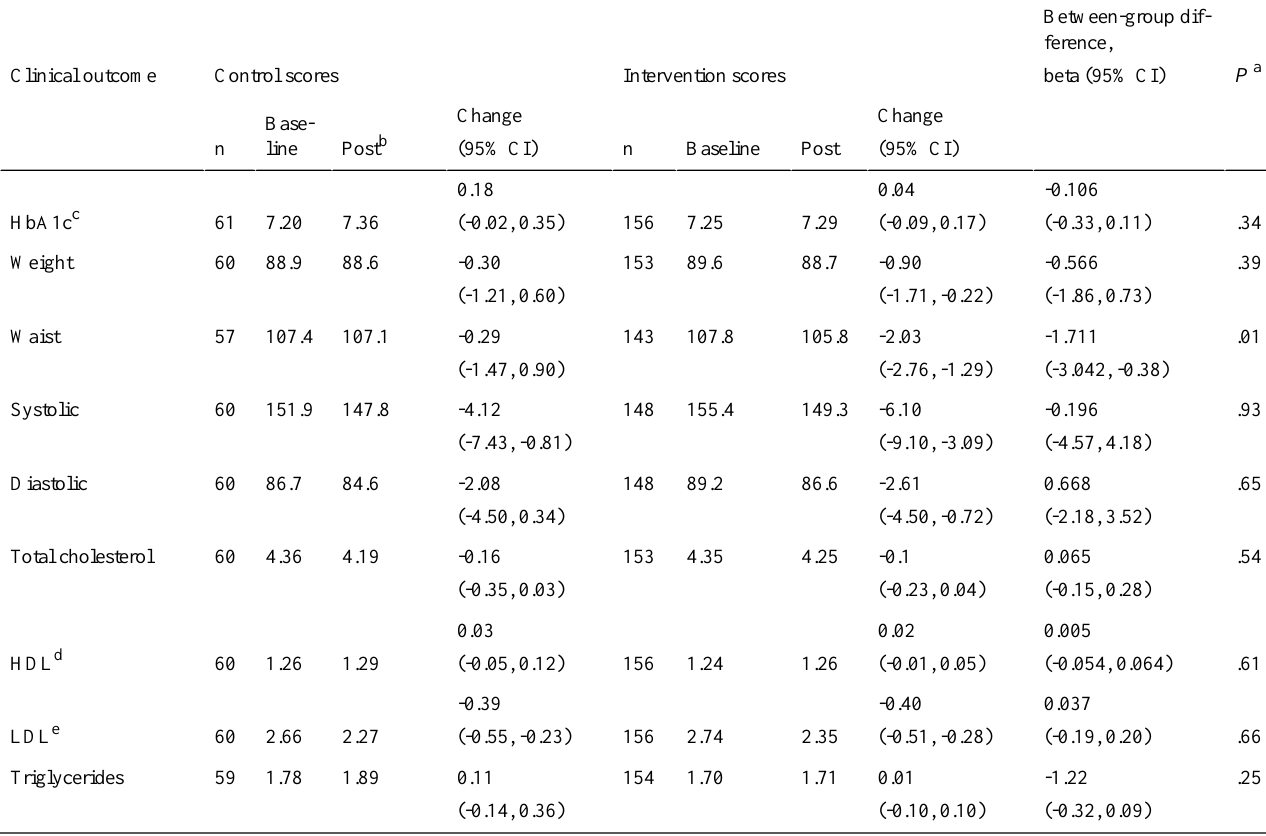
Table 5. Baseline, postintervention, and change scores in clinical outcomes for the diabetes group.